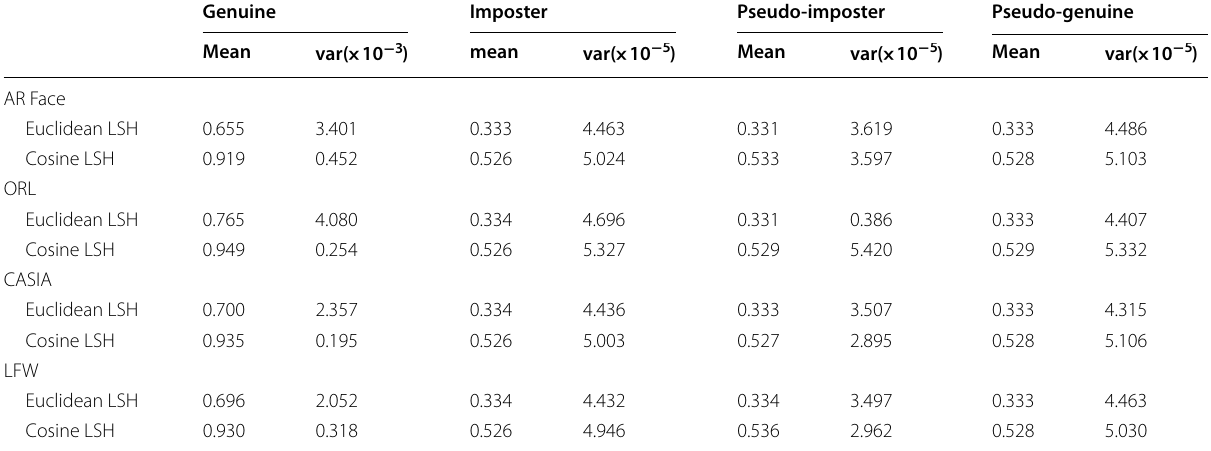
Table 6 The mean values and standard deviation variances of genuine, imposter, pseudo-imposter and pseudo-genuine of proposed scheme based on Euclidean LSH and Cosine